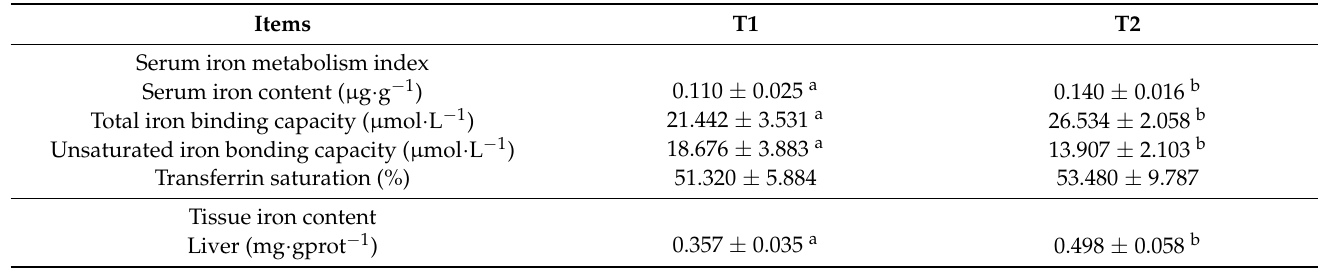
Table 2. Effects of transport stress on serum iron metabolism-related parameters and tissue iron content in broilers.